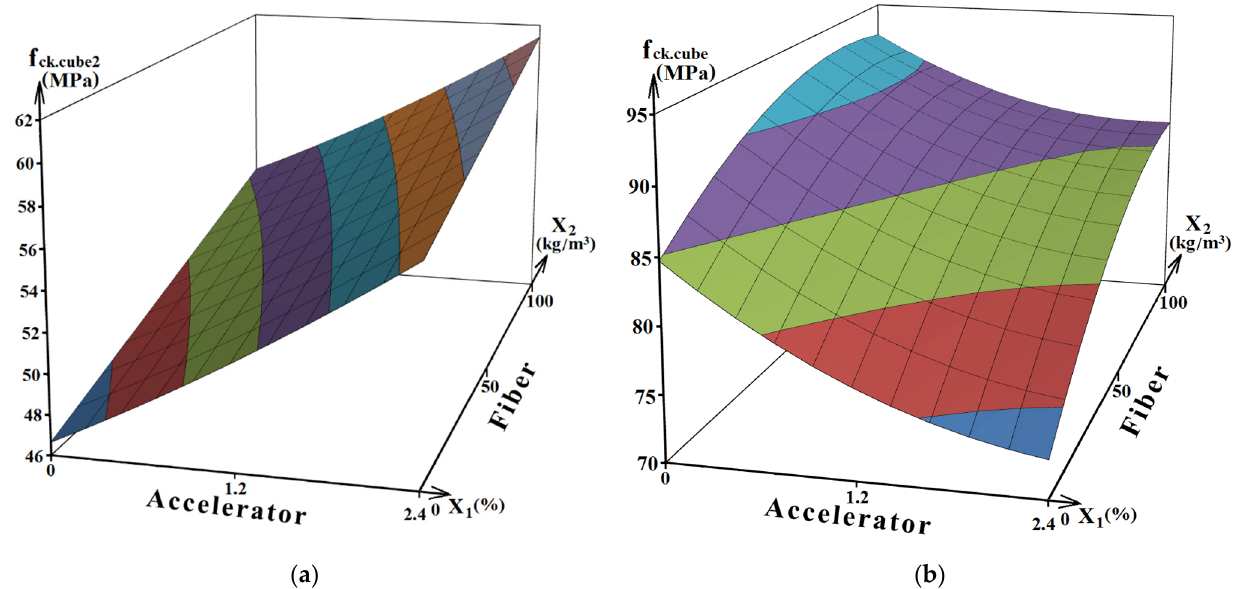
Figure 6. Change in the concrete and fiber-reinforced concrete compressive strengths with usage of varied factors: at the age of 2 days ( a ) and 28 days ( b ).